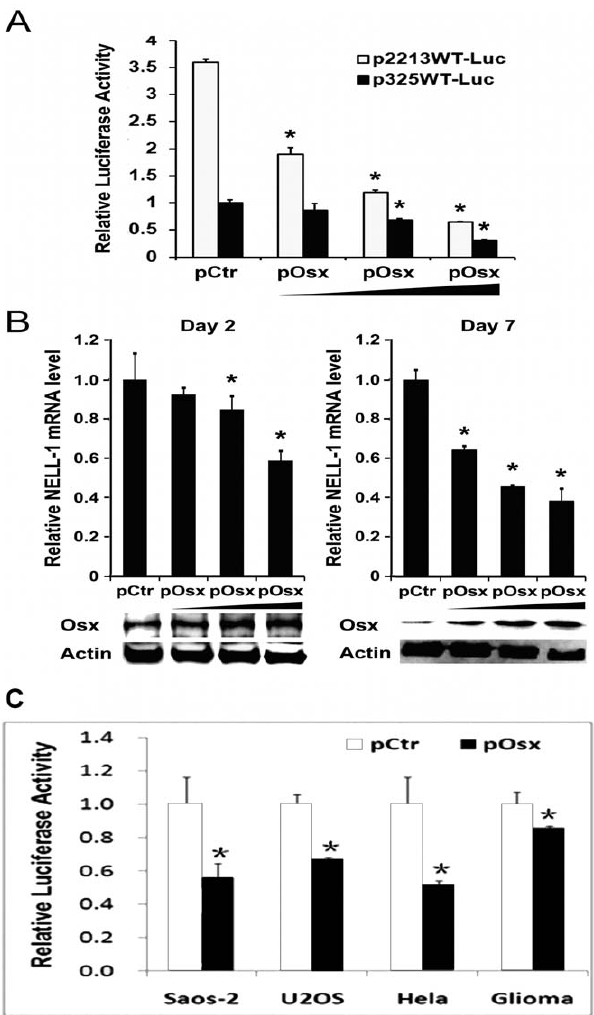
Figure 2. Dose-dependent NELL-1 expression response to Osterix. ( A ) Human NELL-1 promoter is responsive to Osterix in a dose-dependent manner shown by reporter assay. Graph detailing the luciferase activity in Saos-2 cells co-transfected with either the p2213WT-Luc or the p325WT-Luc promoter-luciferase constructs as well as 0, 0.25, 0.5, or 1 ug of Osterix expression vector (pOsx). Data are expressed as a percentage of the luciferase activity of the p325WT-Luc construct in the absence of control vector (pCtr). ( B ) Osterix overexpression decreased NELL-1 mRNA level in Saos-2 cells at 2 days and 7 days post-transfection. Western blot showed Osterix protein levels at 2 days and 7 days post-transfection. (*p , 0.05) ( C ) Osterix transcriptional repression of NELL-1 promoter in osteoblastic and non- osteoblastic cells. A graph detailing the luciferase activity of p325WT- Luc 2 days post-transfection in Saos-2, U2OS, Hela and Glioma cell lines co-transfected with pCtr or pOsx. (*p , 0.05)